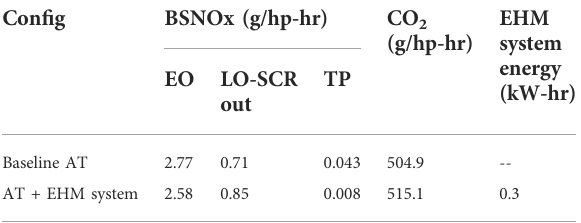
TABLE 4 Hot FTP test